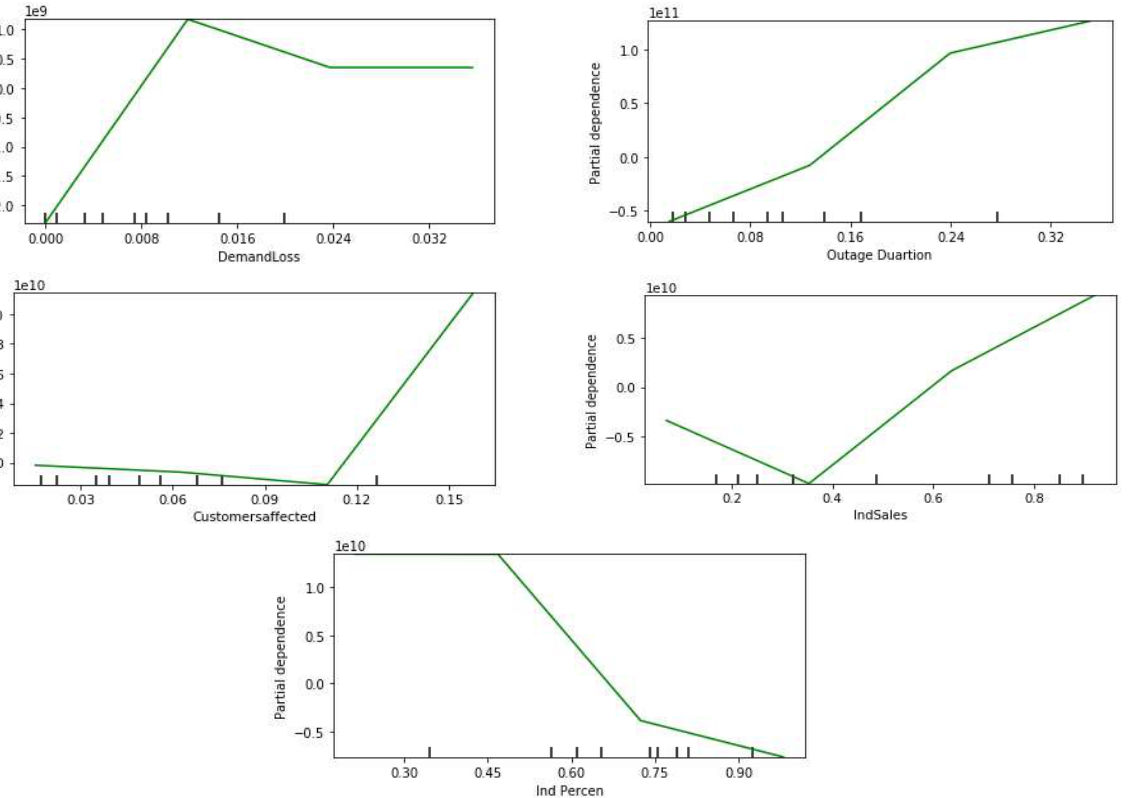
Figure 28. PDP of the top five important features for revenue loss prediction in the heavy wind category.